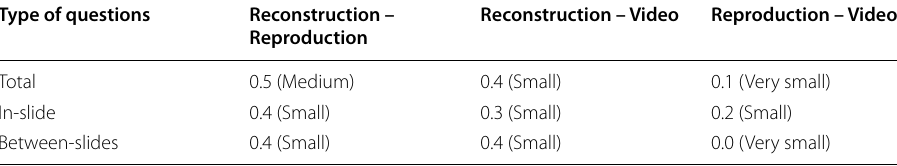
Table 6 Effect sizes (Cohen’s d) between two